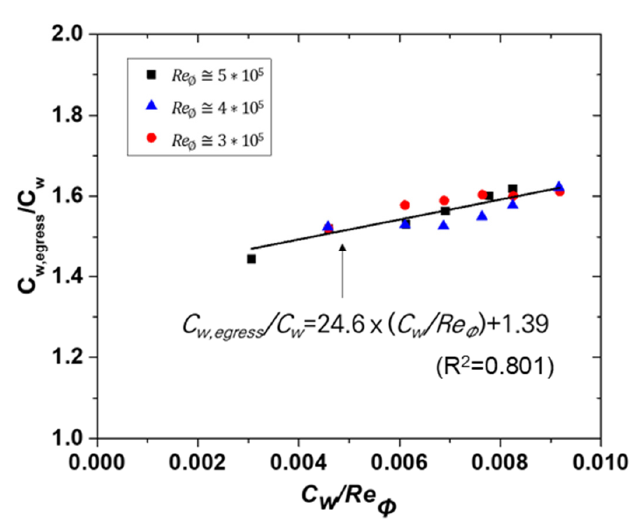
Figure 8. Ingress / egress ratio for coolant mass flow rate at di ff erent rotational Figure 8. Ingress/egress ratio for coolant mass flow rate at different rotational speeds .